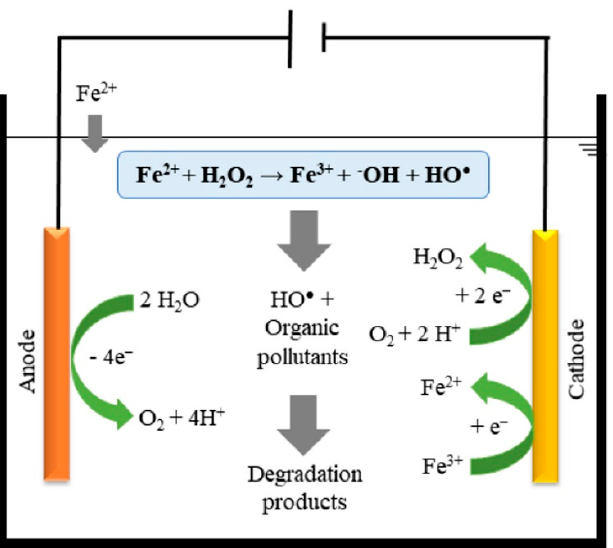
Figure 9. Mechanisms expected in the electro-Fenton process. Reprinted with permission from ref [102]. Copyright 2021 Elsevier.